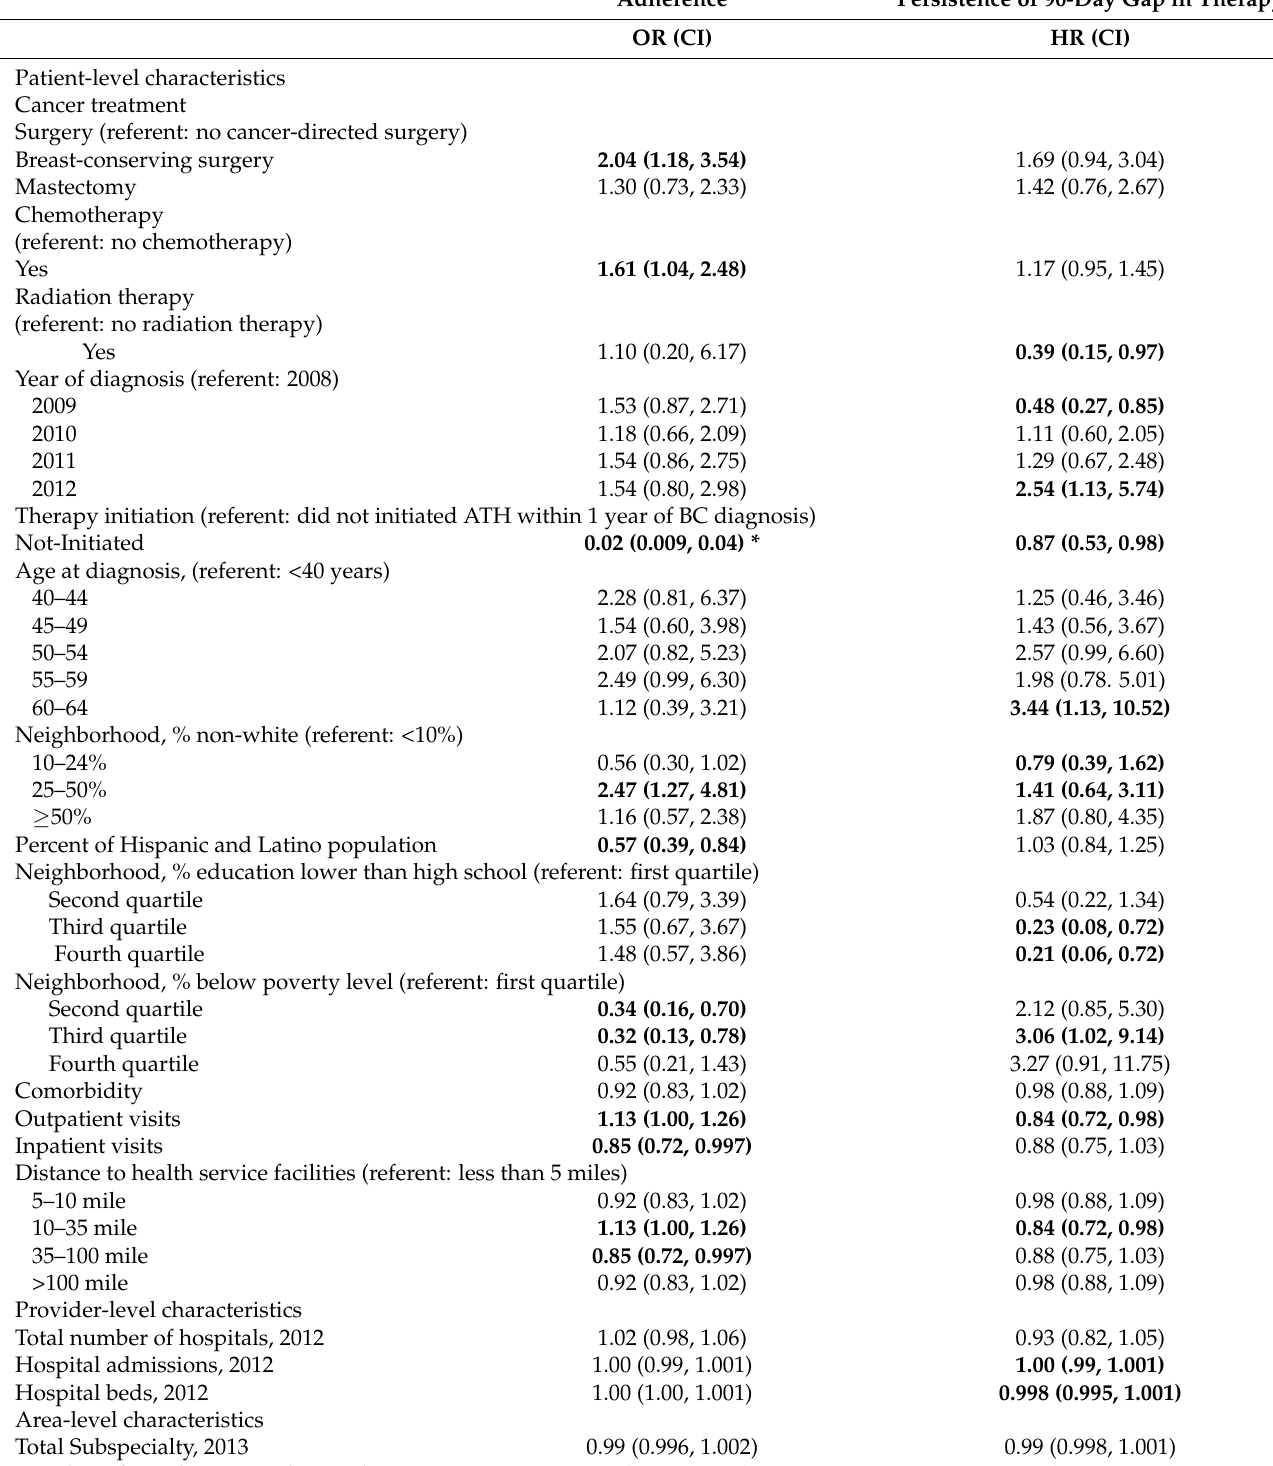
Table 3. Predictors of adherence to and persistence of adjuvant hormonal therapy.